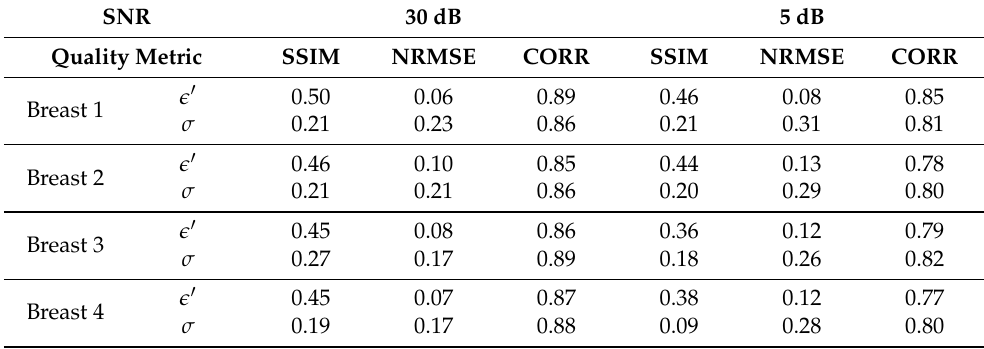
Table 6. Quality metrics for retrieved maps of Figure 10 in the case of high and low noise. SNR 30 dB 5 dB Quality Metric SSIM NRMSE CORR SSIM NRMSE CORR (cid:101) Breast 1